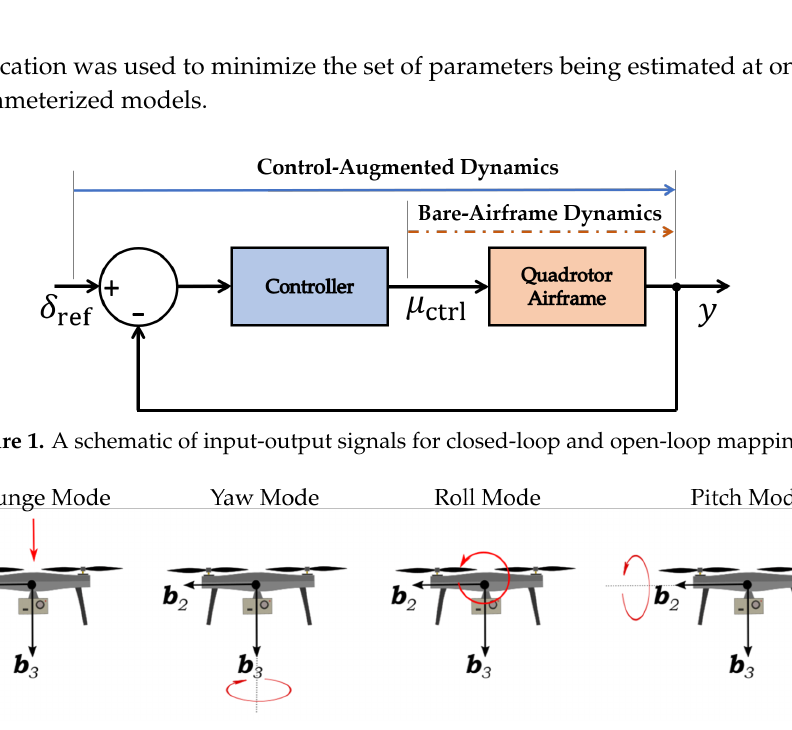
Figure 2. Quadrotor plunge, yaw, roll, and pitch modes.